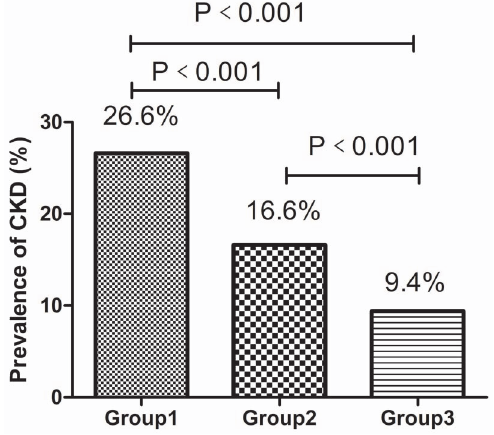
Figure 1. Prevalence of CKD in 1534 subjects based on HW